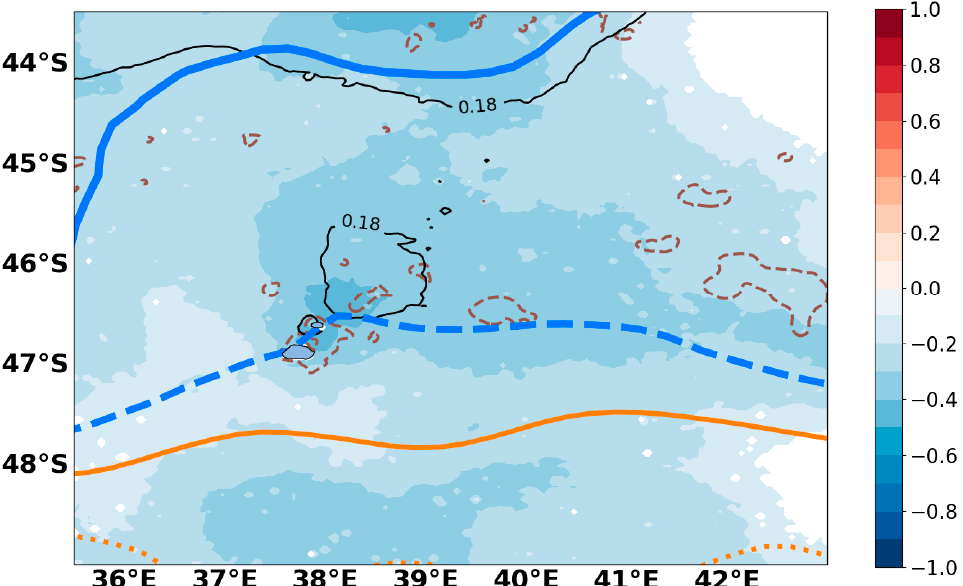
Figure 10. Pearson correlation between monthly mean chlorophyll a and ORAS5 simulated mixed layer depth over the 1997–2020 period. The dashed brown contours show the 1000 m isobath. The black contours illustrate the long-term mean 0.18 mg m − 3 chla isopleths. The solid and dashed thick blue lines show the climatological mean positions of the middle (M-SAF) and southern (S-SAF) branches of the sub-Antarctic Front, respectively. The solid and dotted thick orange lines illustrate the climatological mean positions of the northern (N-APF) and middle (M-APF) branches of the Antarctic Polar Front, respectively.